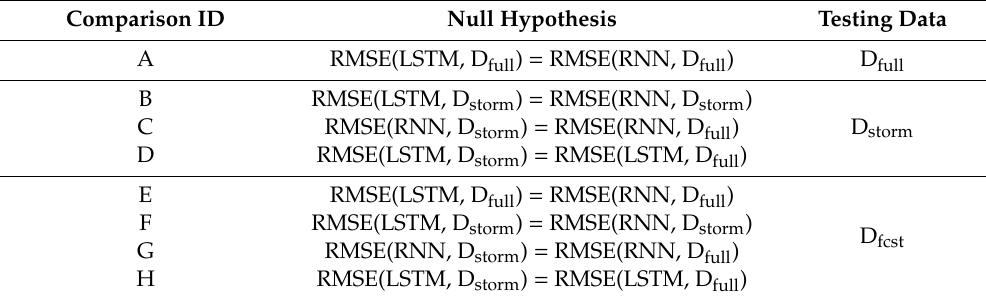
Table 5. t -test null hypotheses for model type and training data comparison.